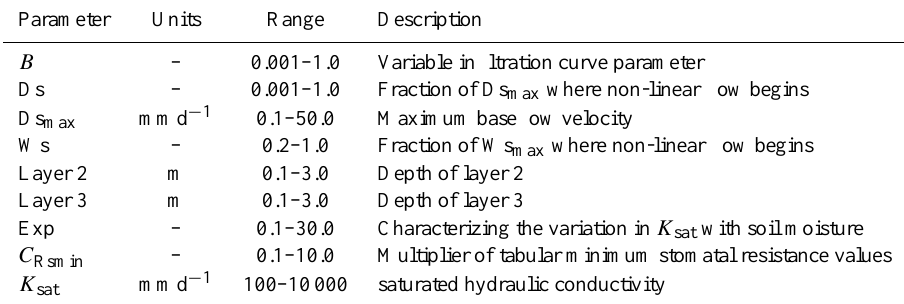
Table 1. Range of VIC parameters used in the 10000 Latin hypercube sample. Each parameter is drawn from a uniform distribution; parameters that cover 2 or more orders of magnitude are sampled in log 10